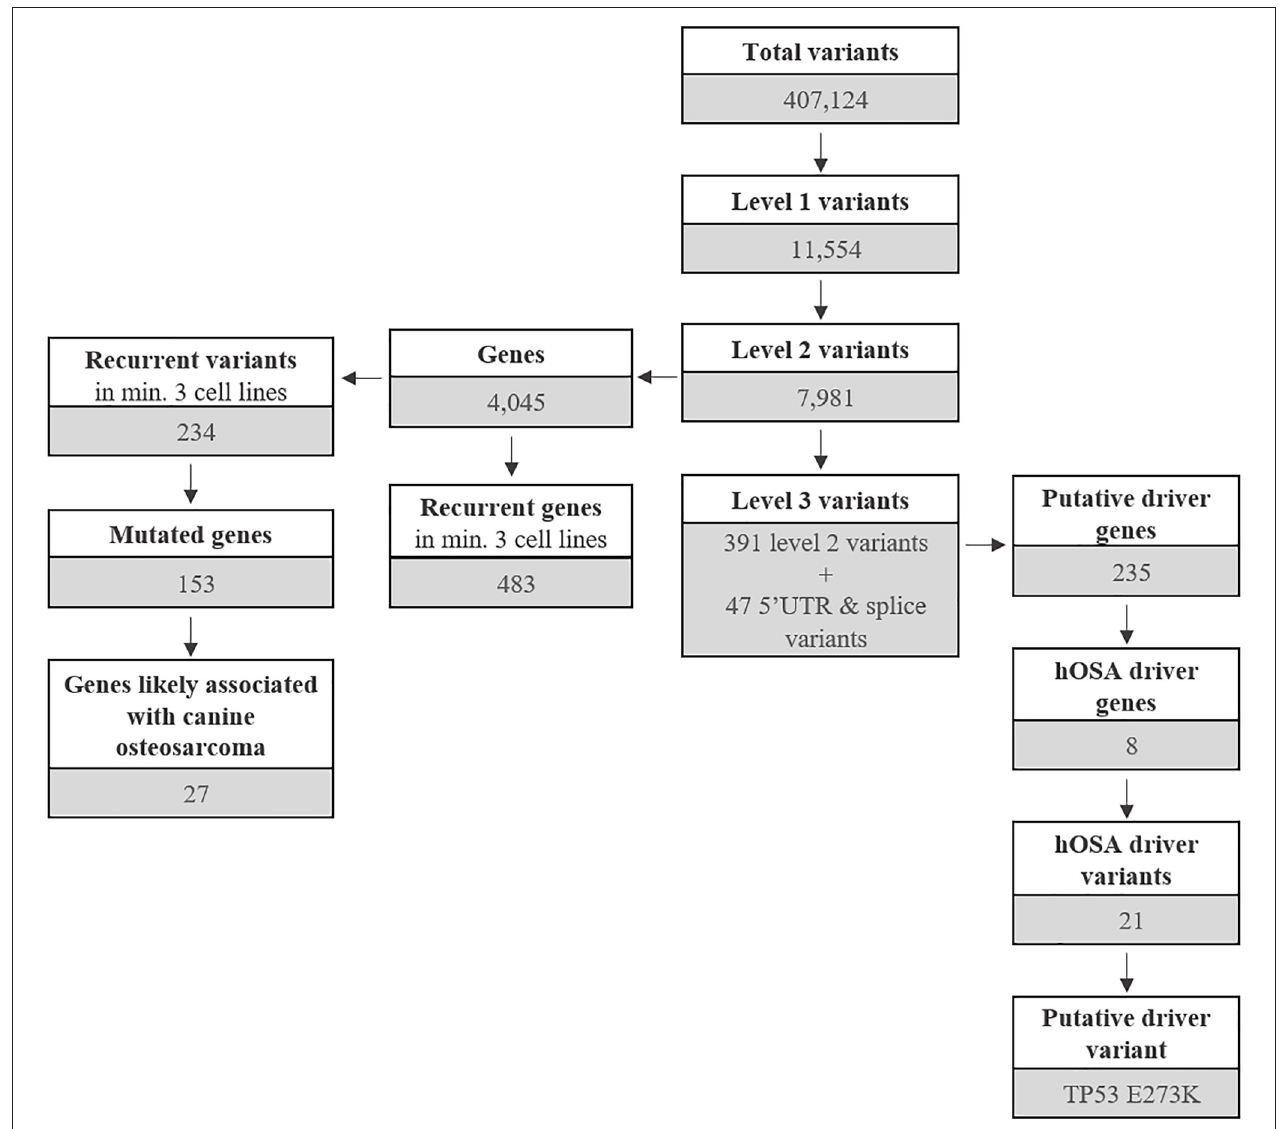
FIGURE 3 | Outline of mutated genes and variants distributed across Level 1, 2, and 3